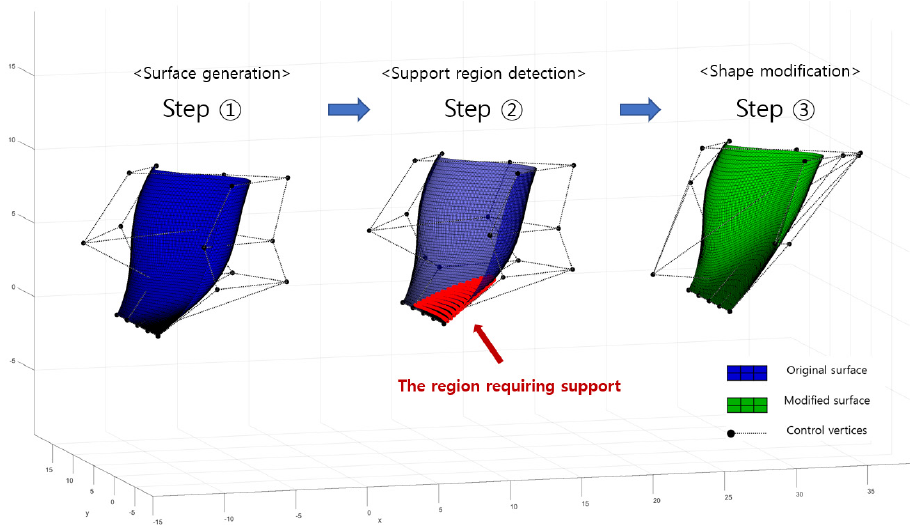
Figure 9. Schematic procedure for local shape modification.